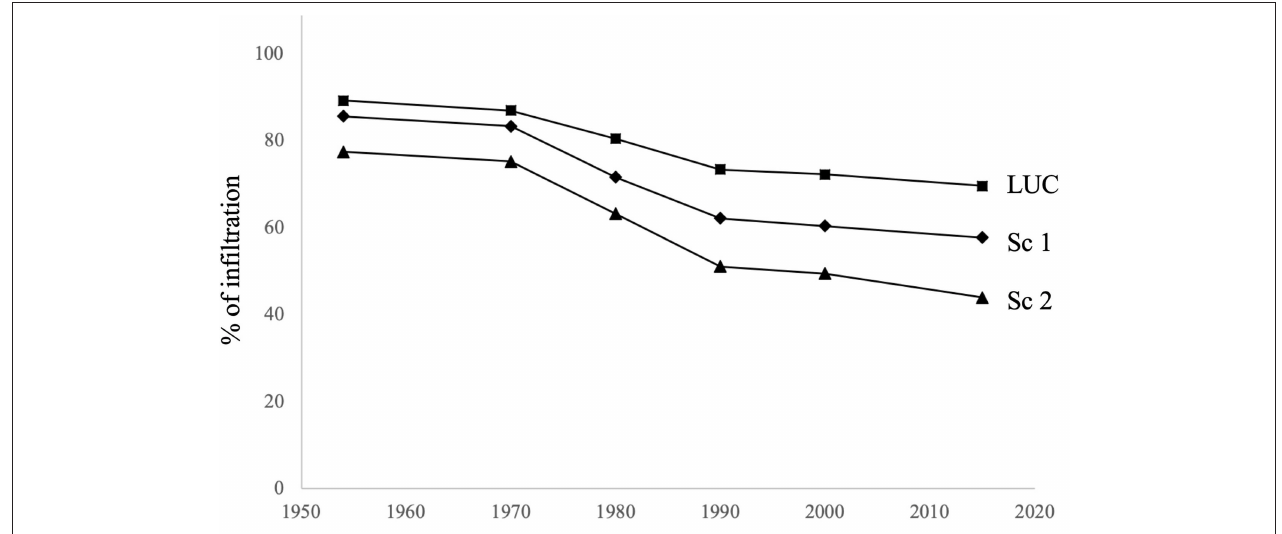
FIGURE 4 | Rainwater infiltration capacities reduction based on LUC across years and hypothetical scenarios, considering fragmentation. Squares represents infiltration changes of infiltration based on land use change (LUC). Rhomboid show first scenario based on fragmentation data (Sc 1) in which urban category reduces its infiltration capacity with edge effect, and the rest of the categories have the highest infiltration rate. Triangles show the second fragmentation scenario (Sc 2) in which edges and perforations also have a reduction in the infiltration rate. See text for specific considerations of each